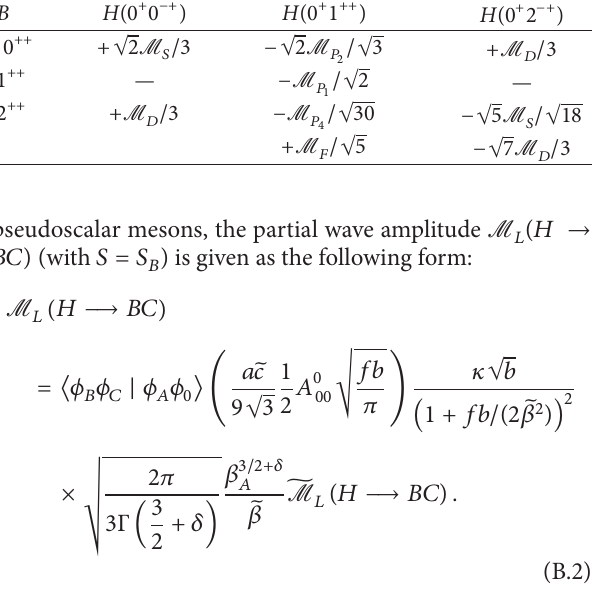
̃ M (𝐻 → 𝐵𝐶) for an initial 𝐿